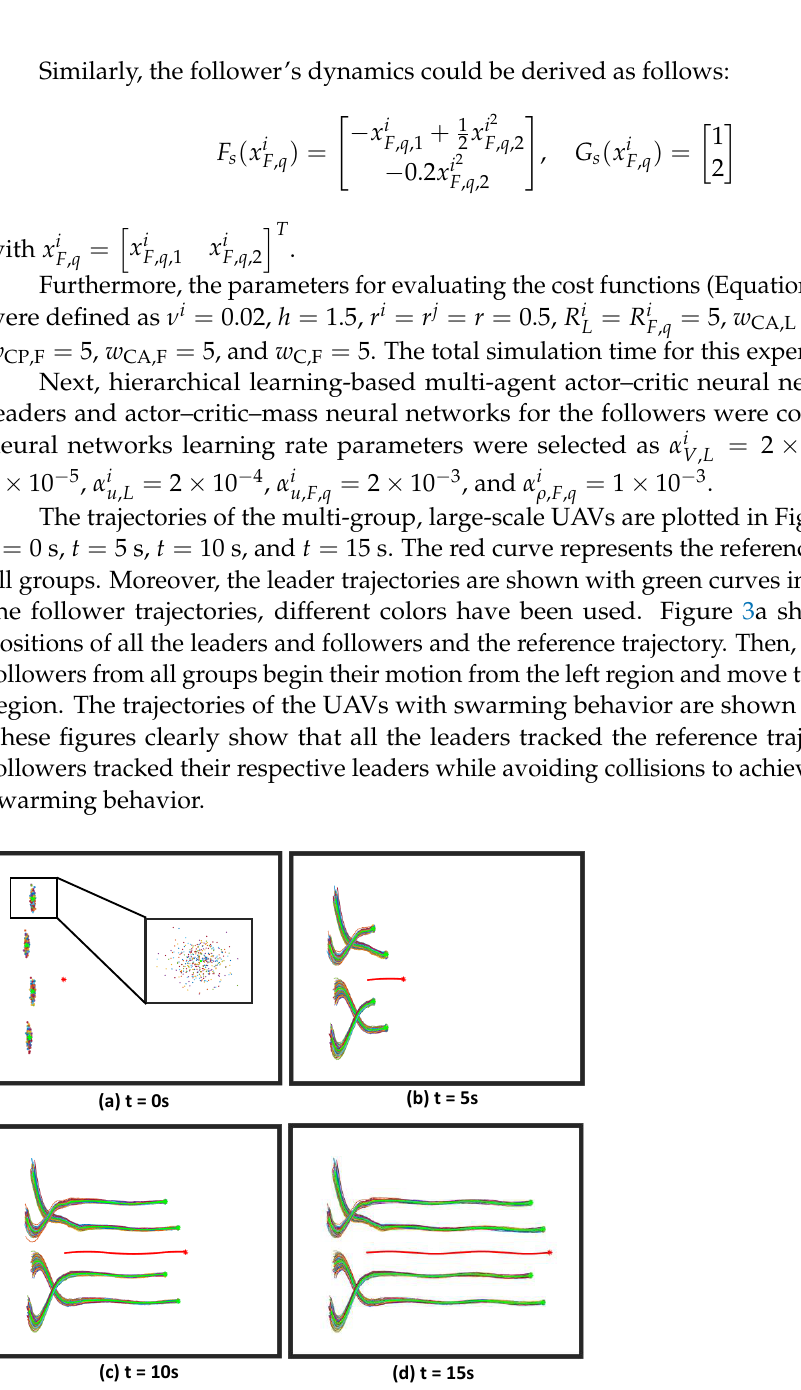
Figure 3. Large-scale leader–follower multi-group swarming. The reference trajectory is denoted by a red curve, the green curve represents the leader trajectory, and the Followers are represented with multiple